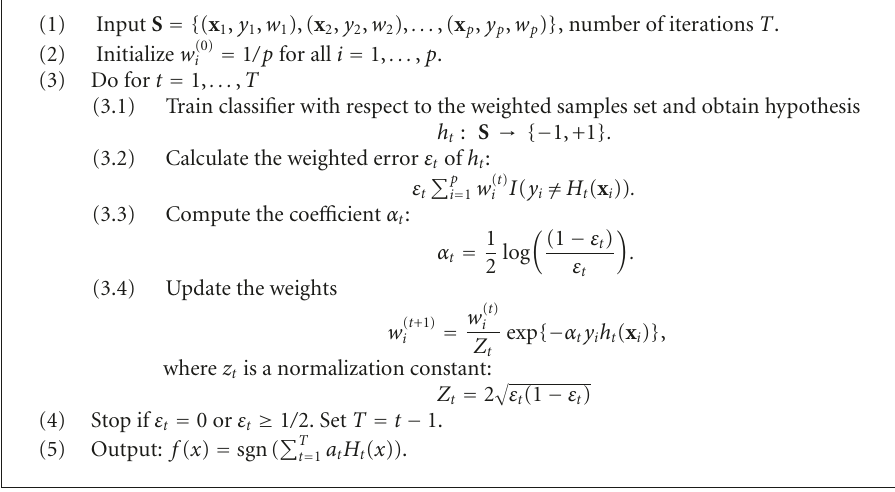
Algorithm 1: The basic AdaBoost procedure.